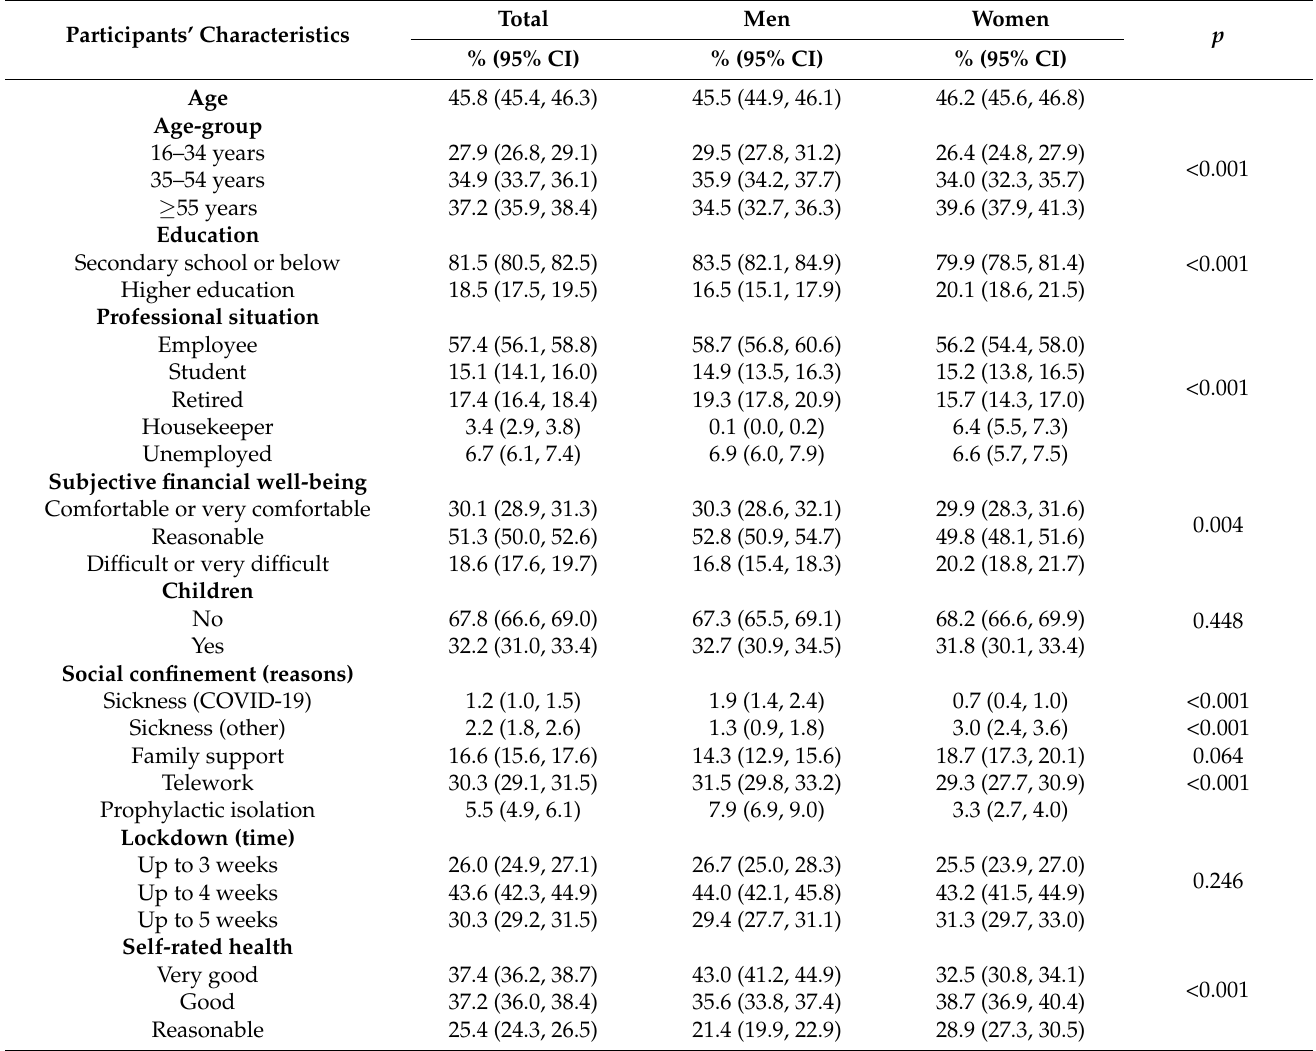
Table 1. Participants’ characteristics of the Portuguese REACT COVID-19